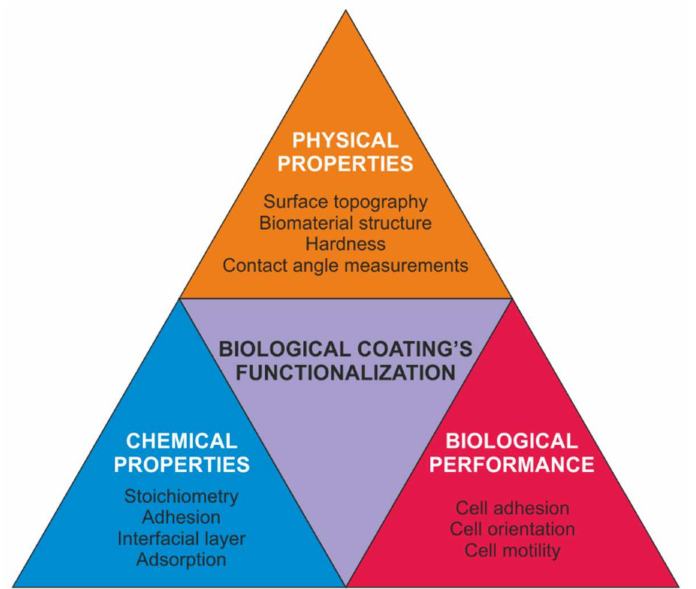
Figure 1. Surface coating functionalization—correlation and influence on the physical, chemical, and biological